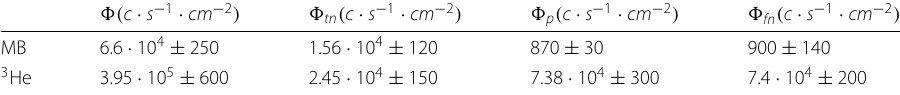
Table 1 Integrated counts of PHS for Fig. 18 (a) (cid:8) , (b) (cid:8) tn , (c) (cid:8) p and the calculated (cid:8) fn from equation 6, for both detectors: Multi-Blade (MB) and 3